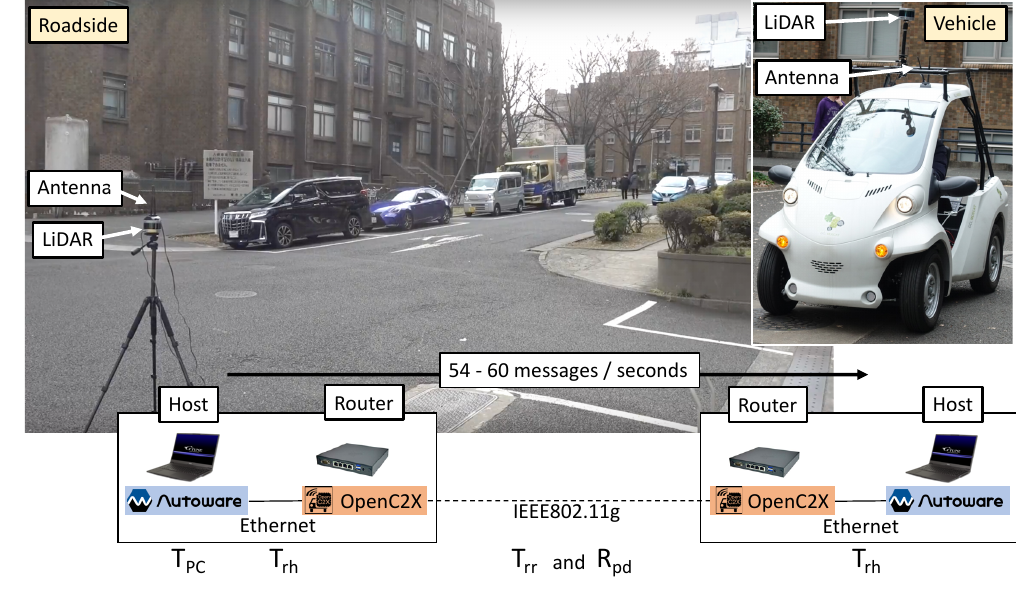
Figure 6. Experimental